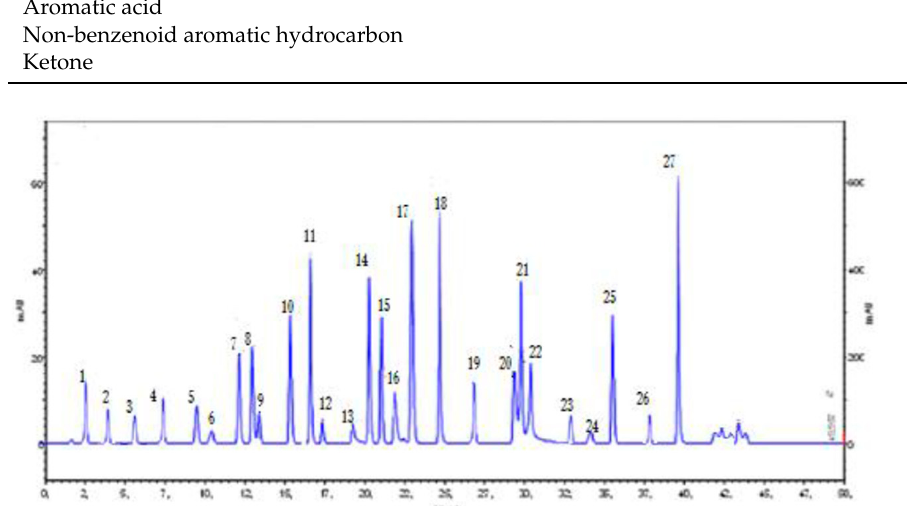
Figure 1. HPLC/MS chromatogram of ethanolic extract of C. incana.